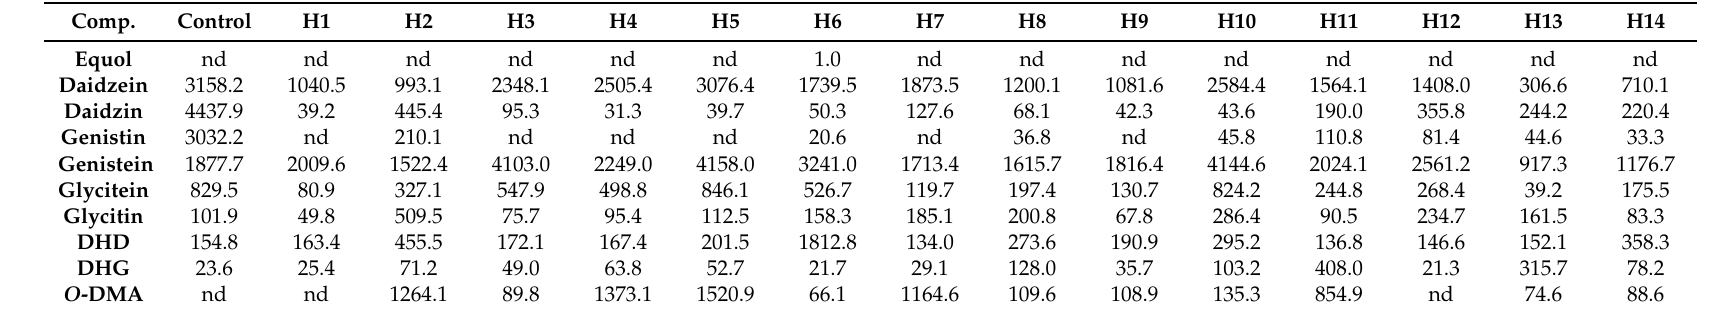
Table 1. Metabolism of isoflavones ( µ M) by adult human gut